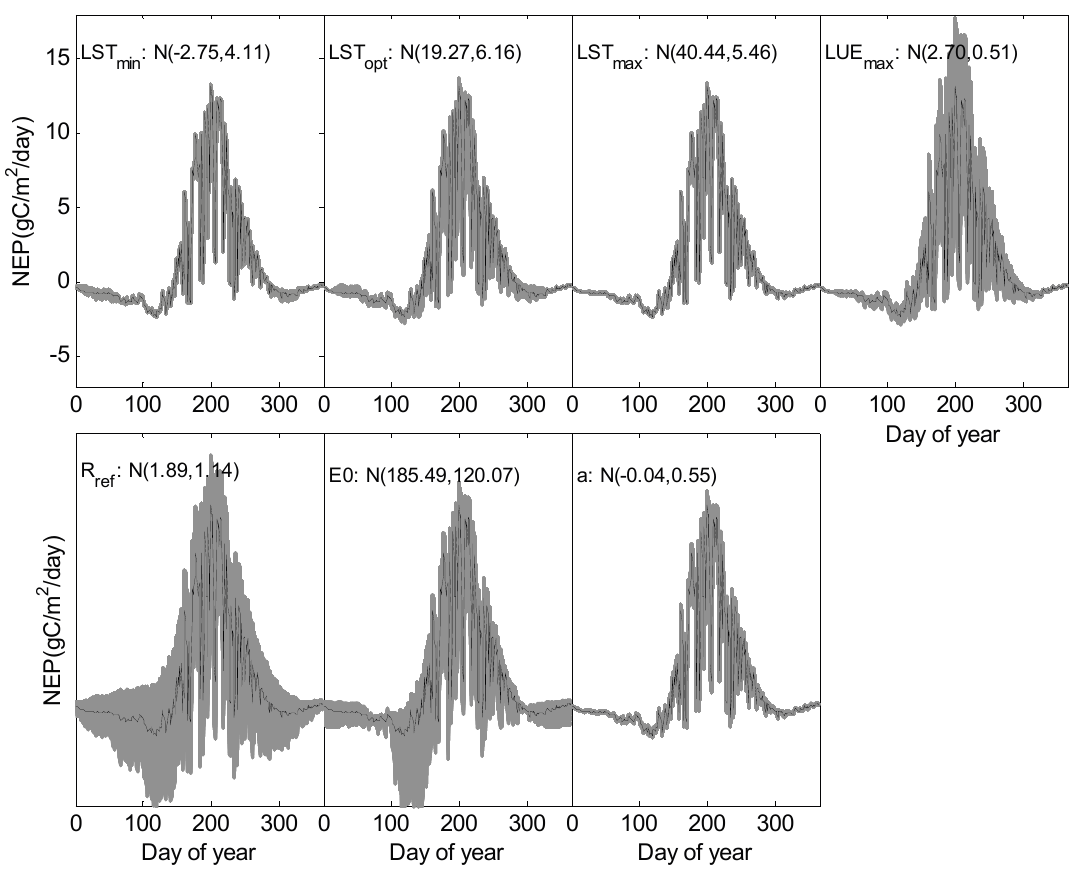
Figure 10. Uncertainties in the NEP caused by parameters in the RS-CFLUX